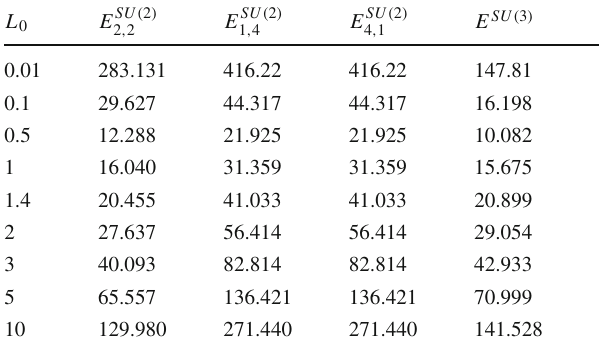
Table 1 Phase transition SU ( 3 ) vs. SU ( 2 ) ⊂ SU ( 3 ) at finite